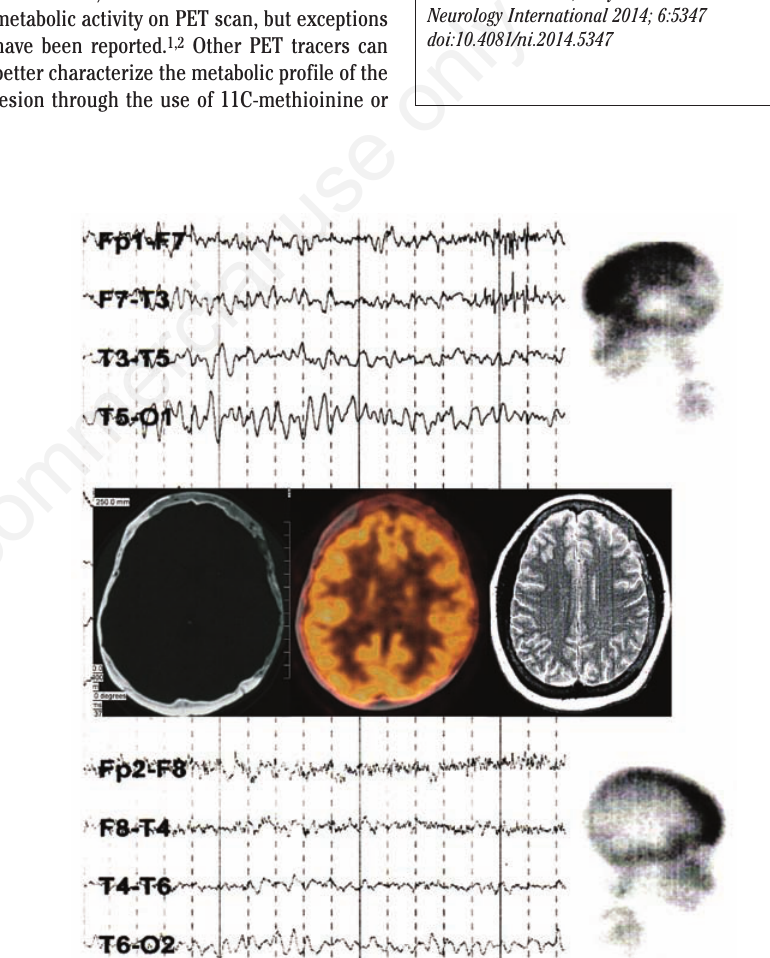
Figure 1. Composite of left hemispheric electroencephalography (EEG) activity at top, versus right hemispheric EEG activity from the same time epoch shown at bottom. Image at left of middle panel reveals head computed tomography (CT) windowed to show only bone densities, with middle color image illustrating PET/CT of the brain; right hand portion of middle panel shows axial T2 weighted section at same level as PET with mild- ly increased T2 signal within the left frontal-parietal focus of fibrous dysplasia (FD). Left lateral planar image of 99mTc MDP bone scan at top right reveals characteristically intense uptake in the left frontal-parietal region suggesting FD as the diagnosis, which stands in contrast to the right lateral view of the skull (right lower